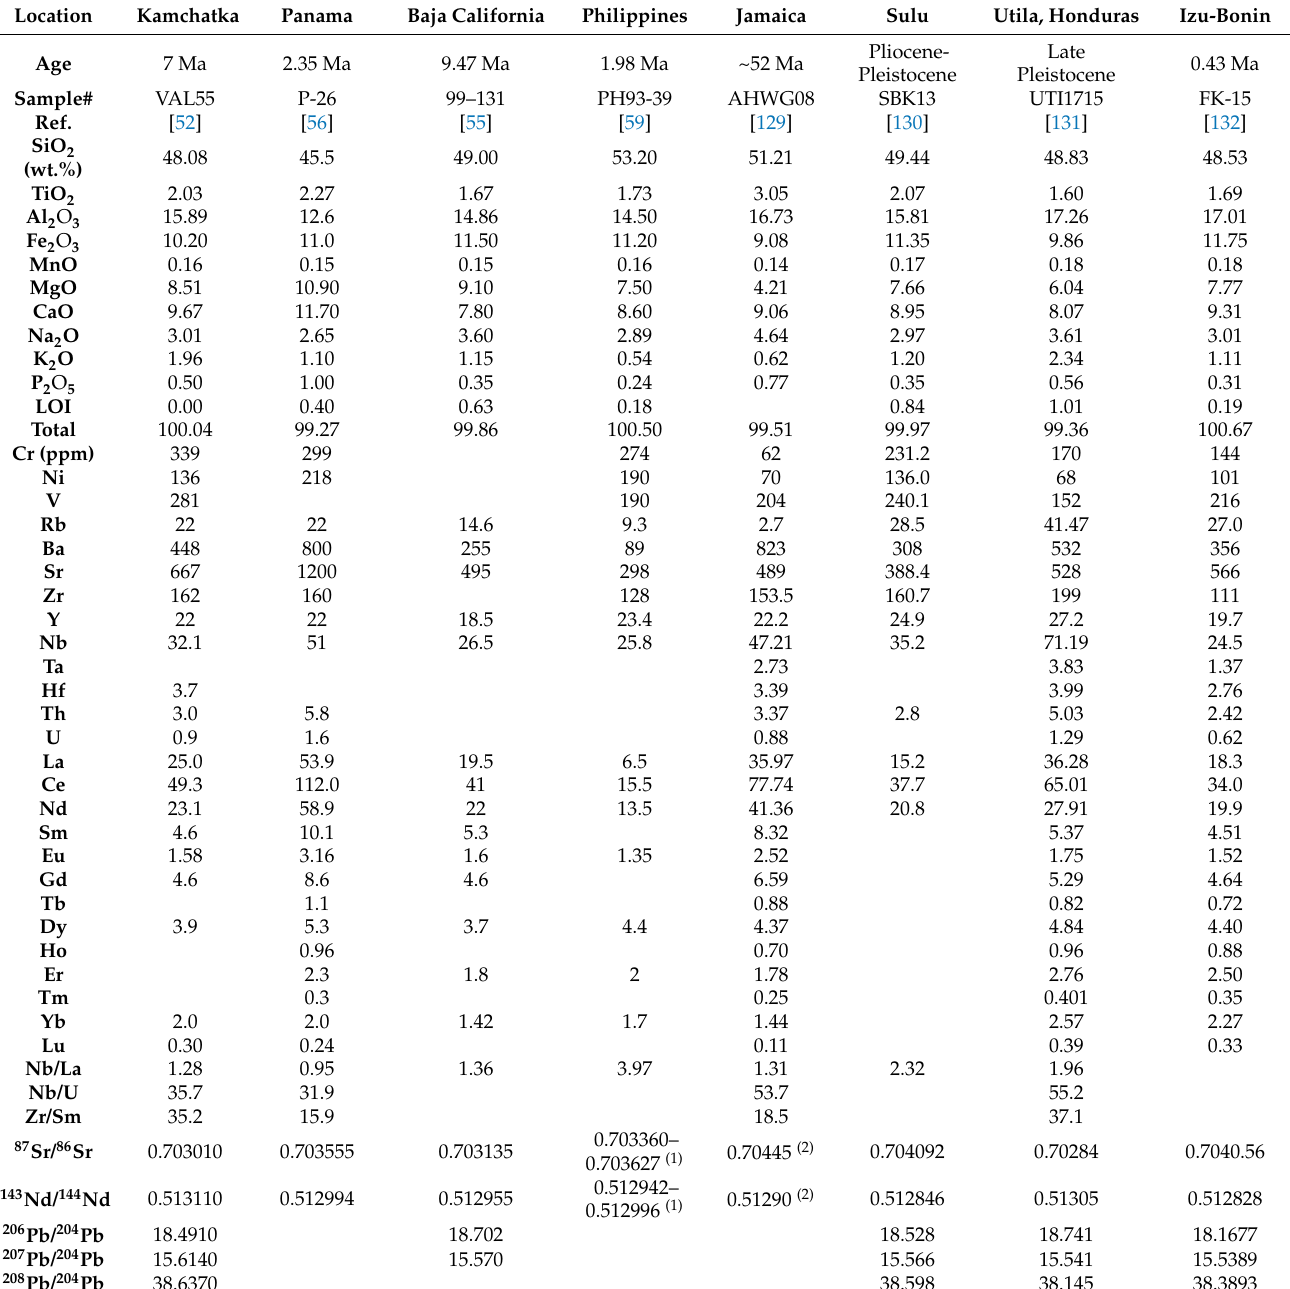
Table 3. Representative compositions of high-Nb basalts (HNB) in volcanic